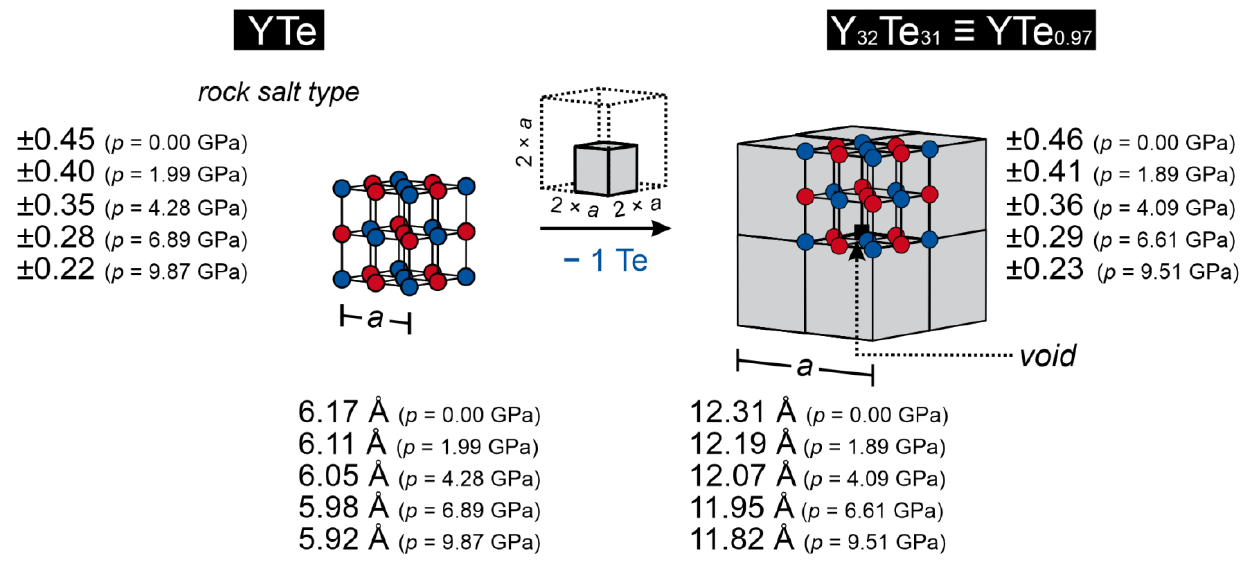
Figure 1. Representations of the crystal structures of YTe and Y 32 Te 31 : the structure model of the latter telluride was constructed based on the crystal structure of YTe, an approach that has also been utilized in previous studies (see main text). Furthermore, the respective averaged Mulliken charges have been included (in units of the elementary charge e ). Table 1. Pressure ranges ( p ), total energies ( E tot ) per formula units (f.u.), and percentage contributions of the different bonding interactions to the net bonding capacities in YTe and Y 32 Te 31 . The percentages of the different bonding interactions were calculated using the approach described